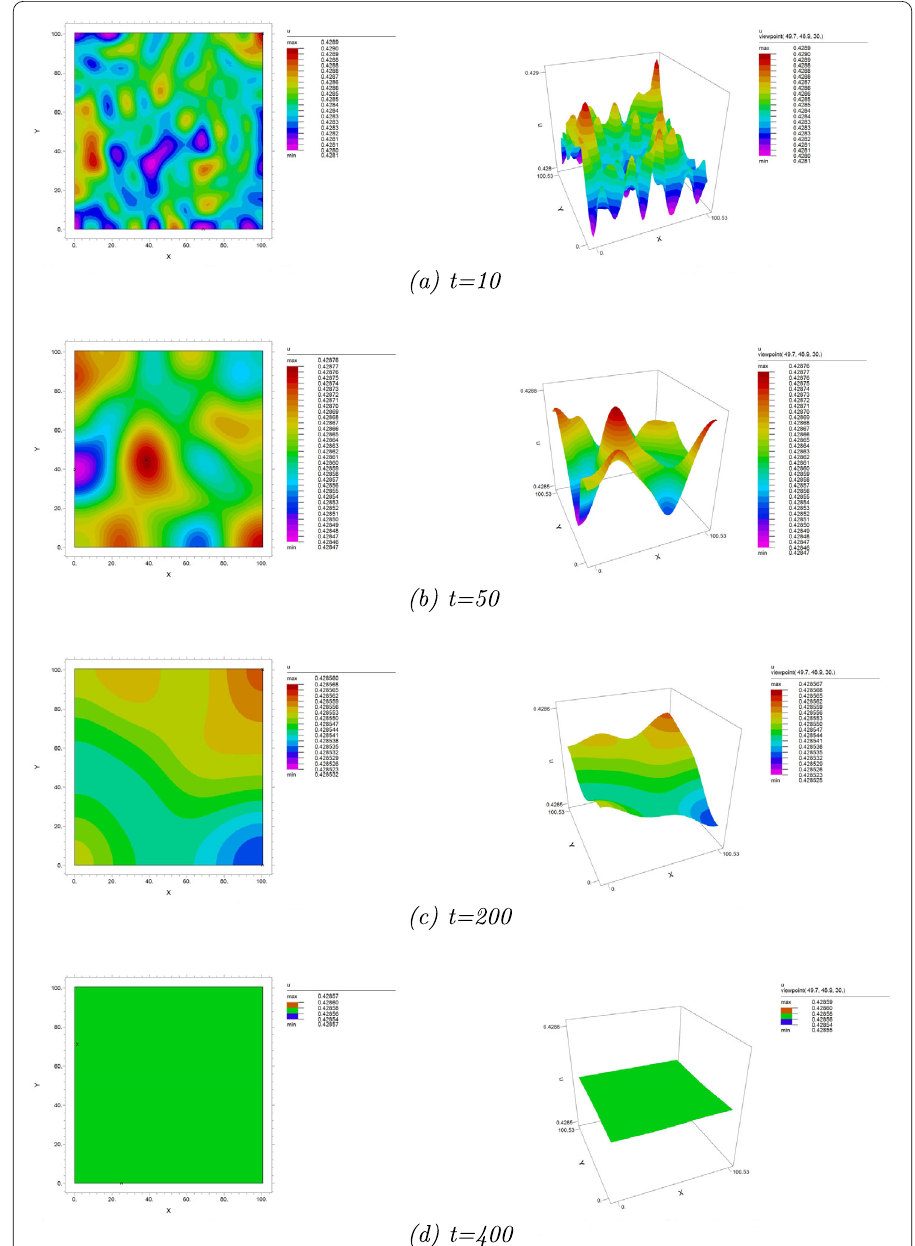
Figure 4 Numerical simulation of system (1.1) with parameters in (4.3), (4.4) and d = 0.5 > d 0 = 0.4807